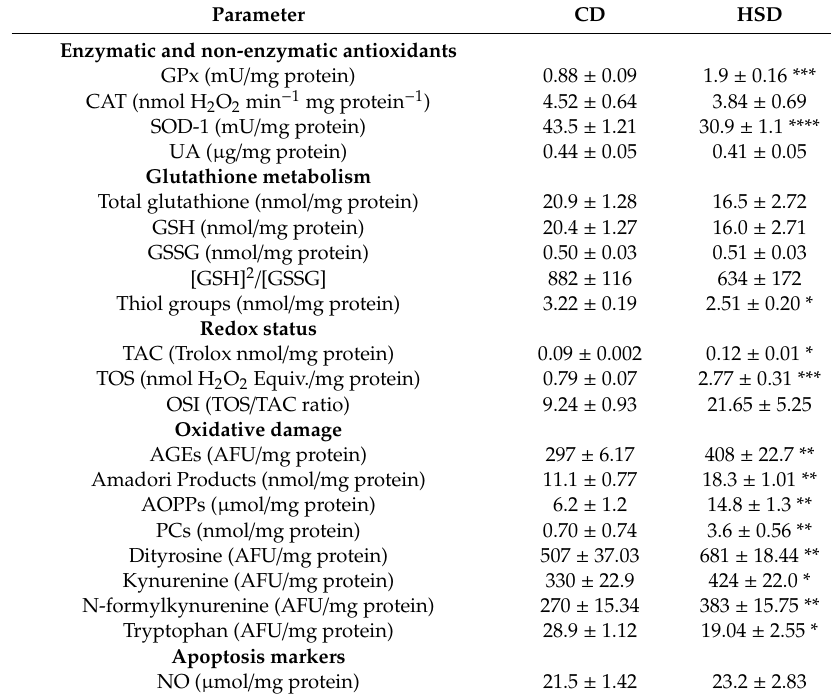
Values are means ± SEMs; n = 10 * di ff erence statistically significant at p < 0.05, ** p < 0.005, *** p < 0.0005